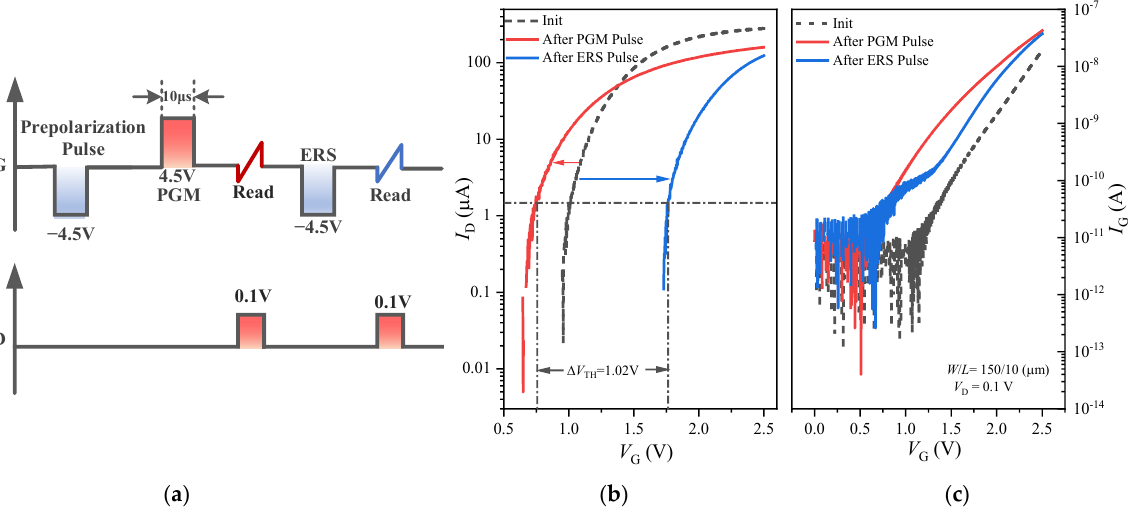
Figure 4. ( a ) Pulse sequence used for finding the MW of the FeFET. ( b ) I D - V G and ( c ) I G - V G curves of FeFET after PGM pulse and ERS pulse compared with the initial state.